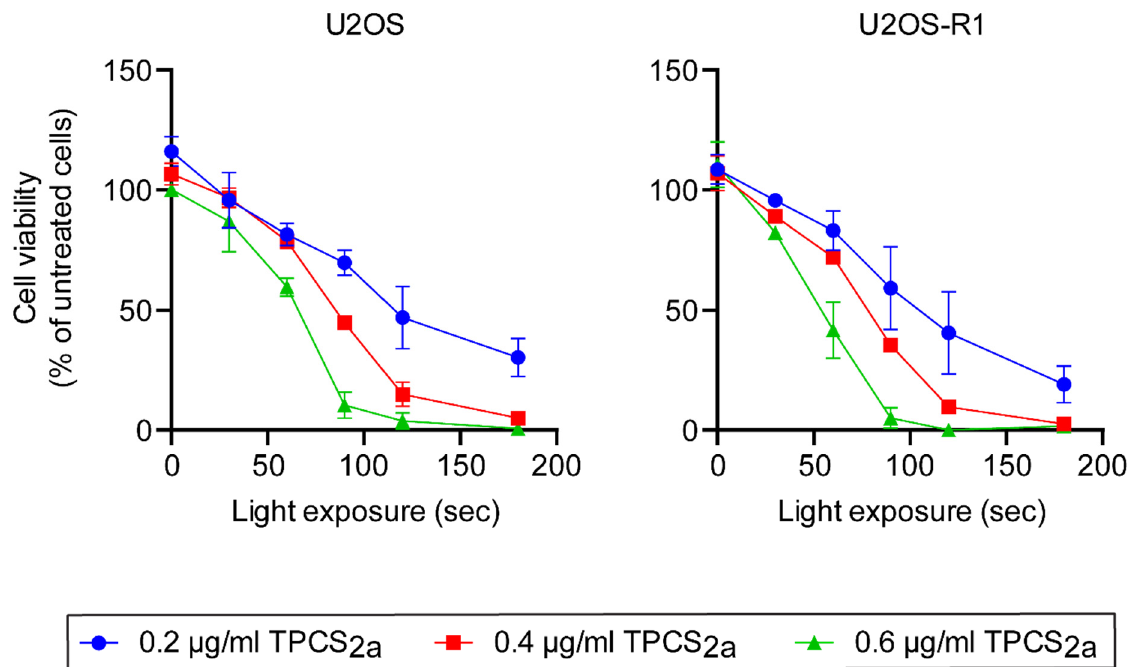
Figure 1. PDT of TPCS2a in U2OS and U2OS-R1 cells. Cells were incubated with 0.2, 0.4 or 0.6 µ g/mL TPCS 2a for 18 h prior to a 4 h chase in photosensitizer-free medium and exposure to blue light for 0–180 s. Cell viability was assessed with MTS assay approximately 48 h after illumination. The data are presented as means relative to the mean of untreated cells (no TPCS 2a treatment). The graph represents the mean of three independent experiments with three replicate samples for each condition in each experiment. 30 s of blue light with 0.2 and 0.4 μ g/mL TPCS2a in U2OS cells was only repeated twice ( n = 2). Error bars ± SEM, n = 3.